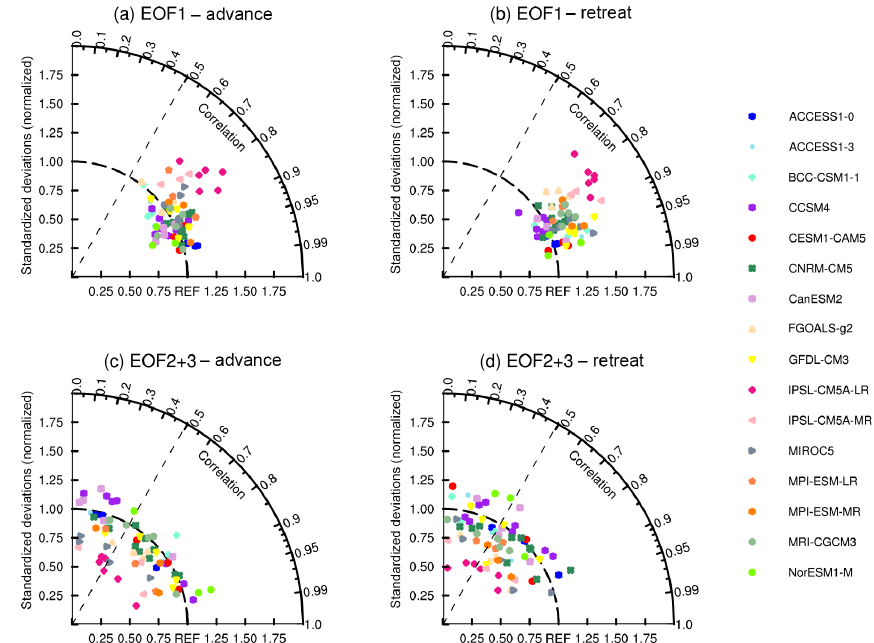
Figure 5. Taylor diagram showing the pattern correlation value (curved outer line) comparing historical CMIP5 ensemble and ERA-Interim SLP eigenvectors, and the percentage of variance explained by each pattern in the historical ensembles as a ratio of the observations for EOF 1 during advance (a) and retreat (b) and the combined EOFs 2 and 3 during advance (c) and retreat (d)